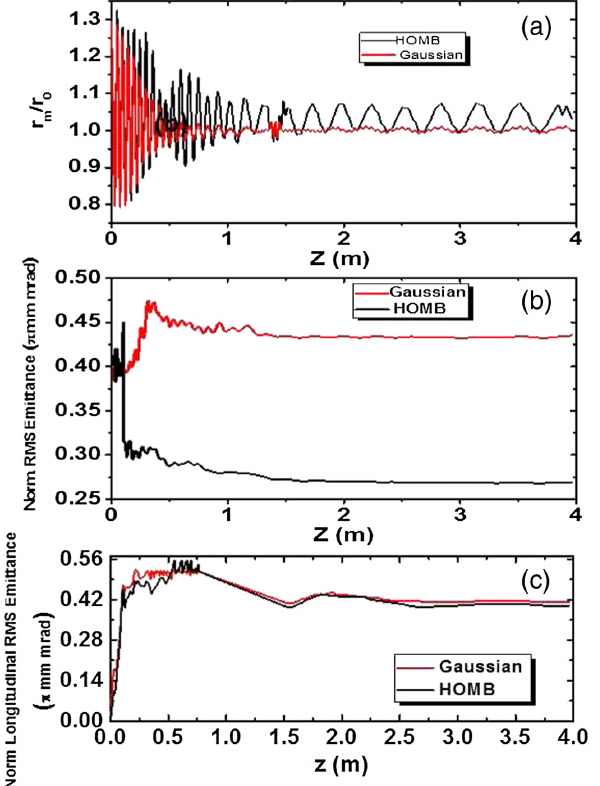
FIG. 9. (a) Damping of the envelope oscillations, and (b) growth of the transverse rms normalized emittance, along the RFQ, for an initial mismatch of 30% and (c) growth of rms longitudinal emittance along RFQ for the mismatch of 30%.